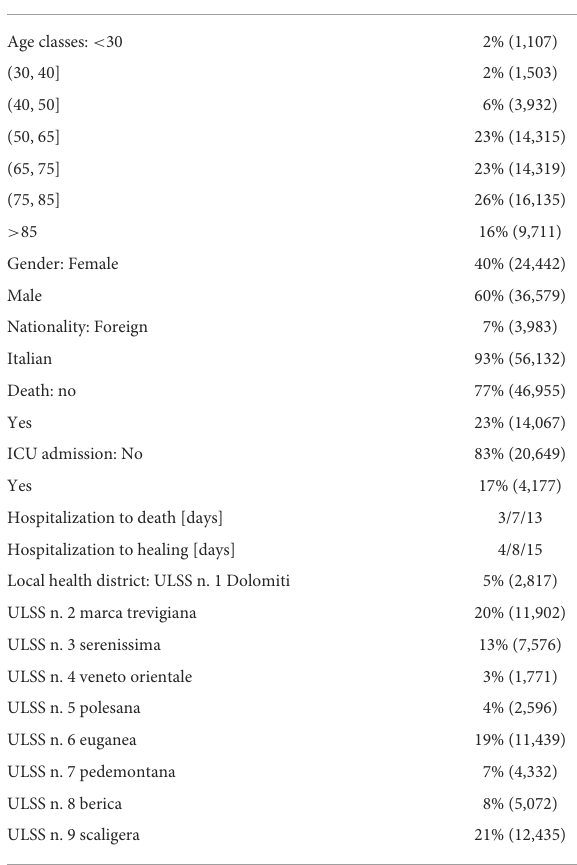
TABLE 1 Continuous data are reported as median (I, III quartiles); categorical data are reported as percentages and absolute